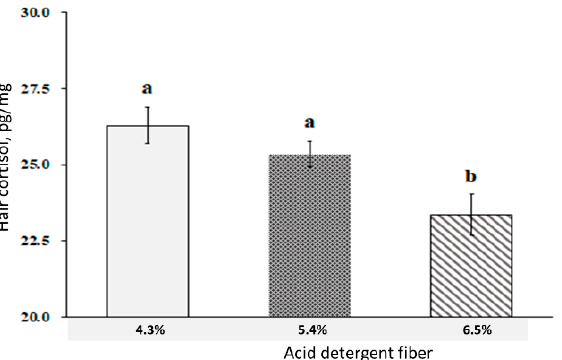
Figure 2. Effect of dietary acid detergent fiber levels in gestation diets on hair cortisol accumulation of sows from day 90 to 112 under high ambient temperature. Values represent means ± standard error. a,b means with different superscripts on the bar differ significantly ( p < 0.05).